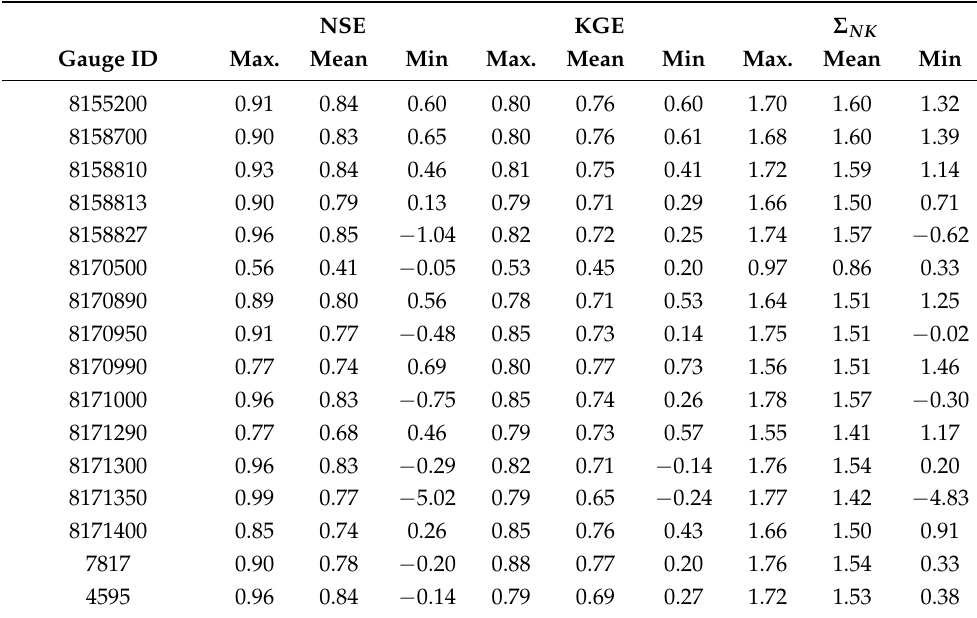
Table 3. Daily ‘goodness-of-fit metrics’ between gauge discharge and synthetic, unbiased discharge time series. NSE KGE Σ NK Gauge ID Max. Mean Min Max. Mean Min Max. Mean Min